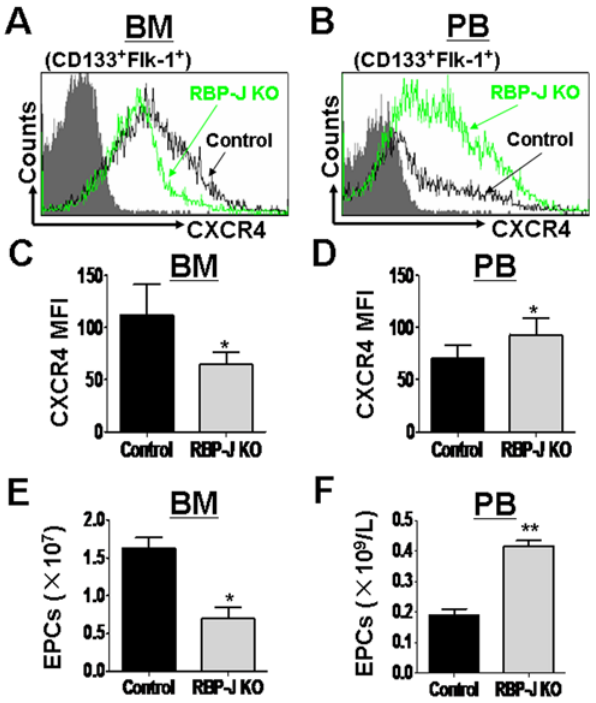
Figure 3. Disruption of RBP-J modulated the CXCR4 expression and the mobilization of EPC. Mice with different genotypes were induced to disrupt RBP-J, and BM and the peripheral blood (PB) cells were analyzed by FACS. ( A, B ) The expression of CXCR4 on CD133 + Flk- 1 + EPCs in BM ( A ) and PB ( B ) of the RBP-J deficient and the control mice was analyzed by FACS. ( C, D ) FACS analyses shown in ( A ) and ( B ) were repeated, and MFI of the CXCR4 expression was analyzed statistically (bars=mean 6 SD; n=5; * P , 0.05). ( E, F ) The number of CD133 + Flk-1 + EPCs in BM ( E ) and PB ( F ) of the RBP-J deficient and the control mice was determined by cell counting and FACS analysis (bars=mean 6 SD; n=5; * P , 0.05; ** P , 0.01).